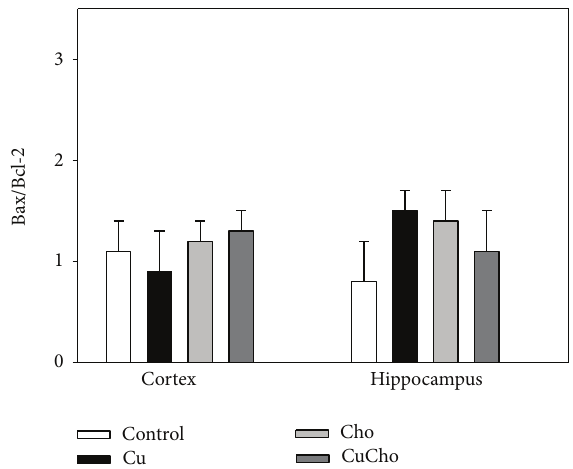
Figure 9: Bax/BcL-2 ratio in brain cortex and hippocampus. Treatments are indicated with different colors, control (white bars), Cu (black bars), Cho (gray bars), and CuCho (dark gray bars). Samples were analyzed as indicated in Section 2.11.1. Results are expressed as the mean ± standard deviation (SD) of 10 rats. There were no significant differences between